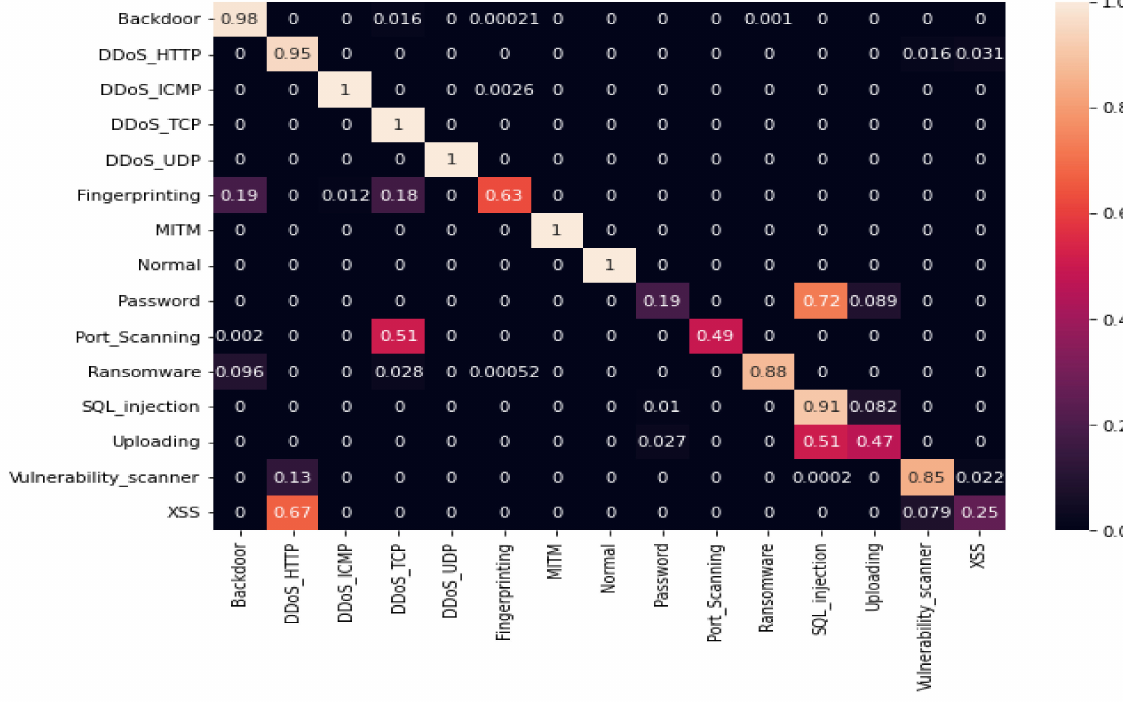
Figure 12. The confusion matrix for 15 classes in the Edge-IIoT–Inception Time validation: DDoS- HTTP, backdoor, DDoS-ICMP, DDoS-TCP, DDoS-UDP, fingerprinting, normal, password, port scan- ning, SQL-injection, uploading, XSS, vulnerability scanner, ransomware, and MITM; all values between 0.59 and